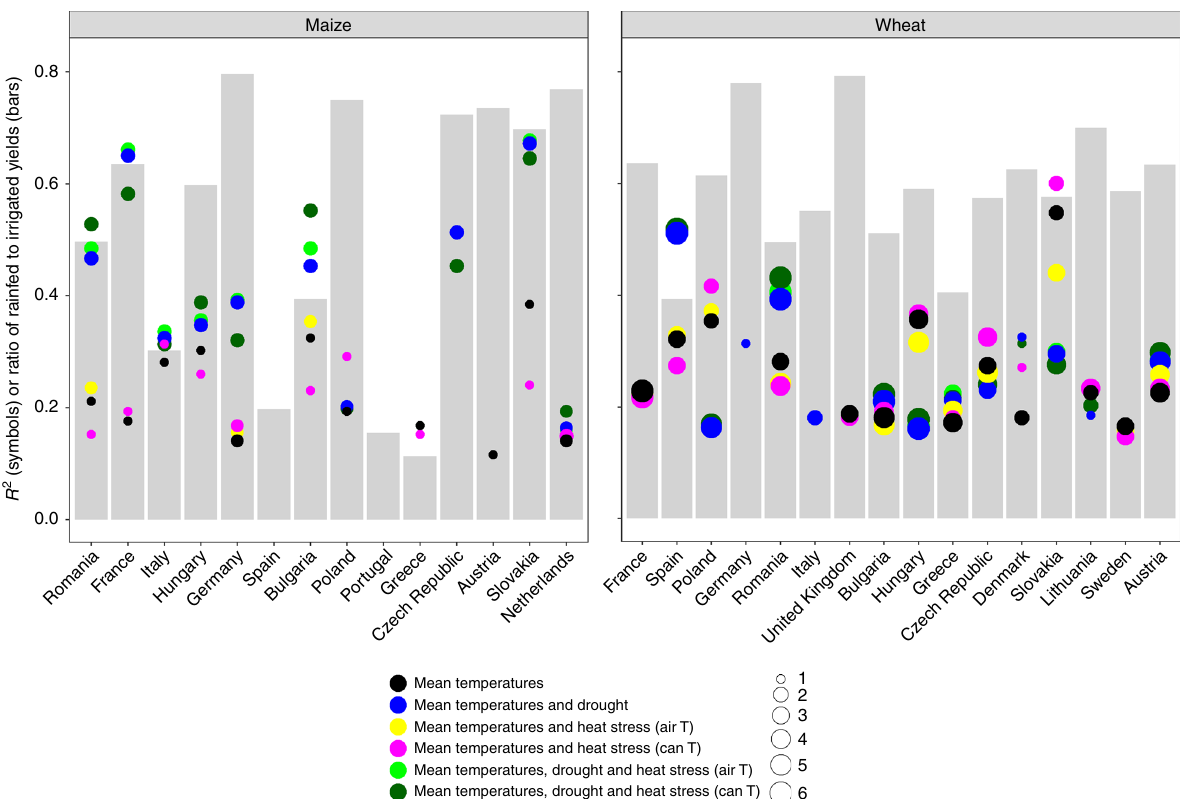
Fig. 1 Climatic variation in historical national crop yields as captured by crop models. The amount of variation in the observed yields as reported in FAO- stats for the period between 1984 and 2009, as quanti fi ed by the coef fi cient of determination ( R 2 ), correlation explained by each of the six simulation sets (black — mean temperature effects only, blue — mean temperature and drought effects, yellow — mean temperature and heat stress with air-temperature effects, magenta — mean temperature and heat stress with canopy-temperature effects, light green — mean temperature, drought, and heat stress with air- temperature effects, and dark green — mean temperature, drought, and heat stress with canopy-temperature effects). Each point represents the mean of the correlation coef fi cient for the eight winter wheat models and six maize models. The size of the dot indicates the number of models with signi fi cant correlations for that simulation set and considered in the respective mean. Gray columns serve as an environmental index indicating the model median average of the ratio of rainfed to irrigated yields for each country. For each plot, countries are ordered by production area in descending order. Note that simulations were only for winter wheat, whereas FAO-stats does not distinguish winter and spring